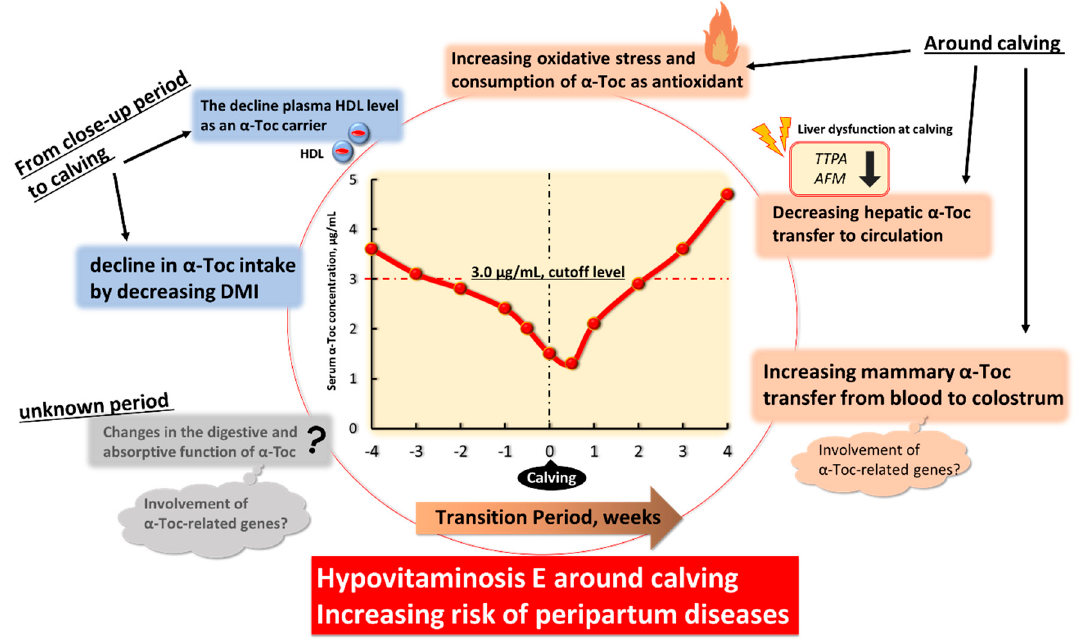
Figure 2. Six candidate physiological factors causing decreased blood α -tocopherol ( α -Toc) level and hypovitaminosis E in transition high-yield dairy cows. Abbreviations: DMI, dry matter intake; TTPA , α -tocopherol transfer protein gene; AFM , afamin gene; HDL, high density lipoprotein.